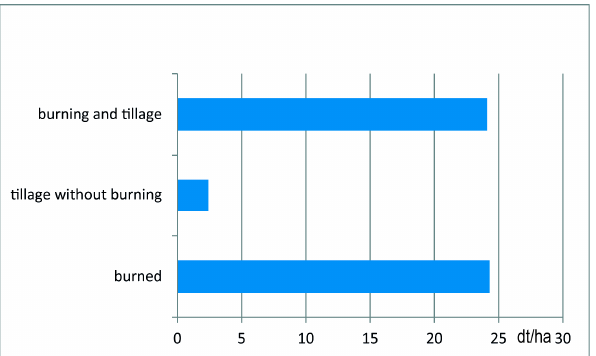
Figure 8. Yields of the year 2016 in Forchtenberg (dt/ha).